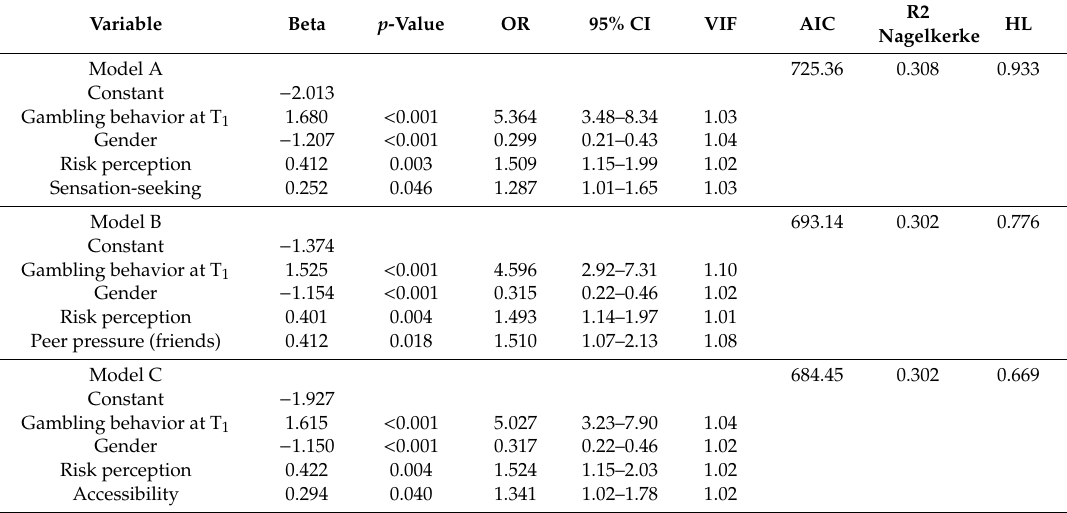
Table 4. Adjusted multivariate logistic regression